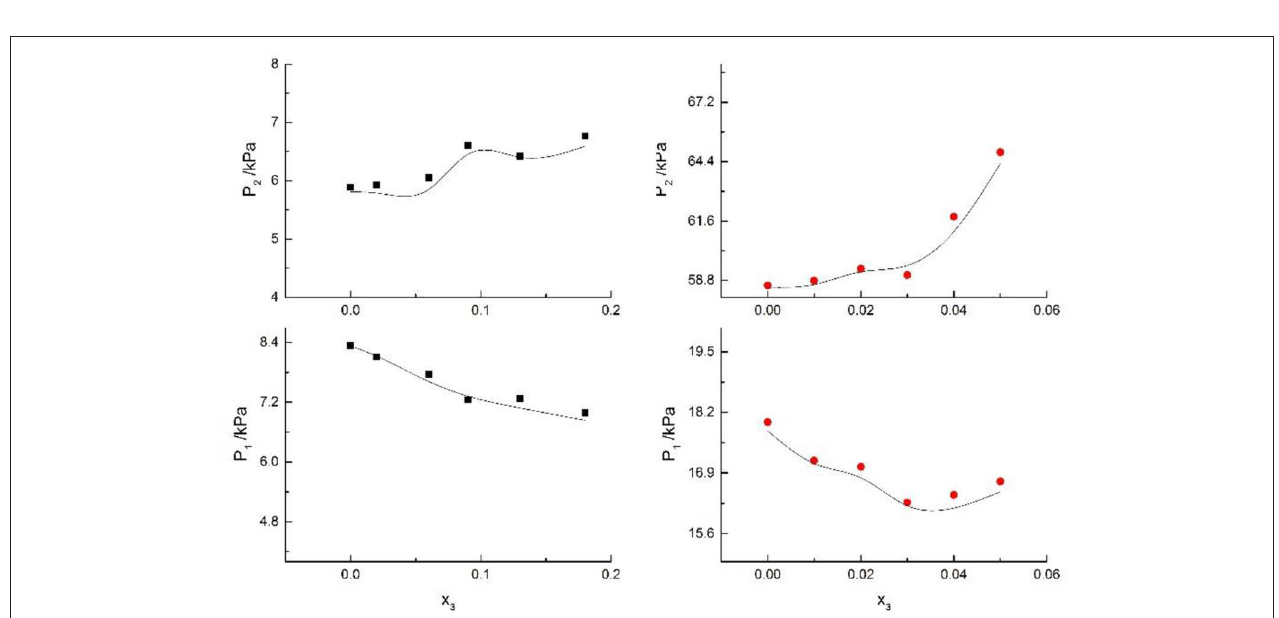
FIGURE 10 | Correlation of VLE data for H2O(1) + CH3OH(2) + KI(3) system. Filled symbols ( (cid:4) x2 = 0.08 and T = 316K; • x2 = 0.46 and T = 341K) indicate experimental data; curves indicate correlation of the